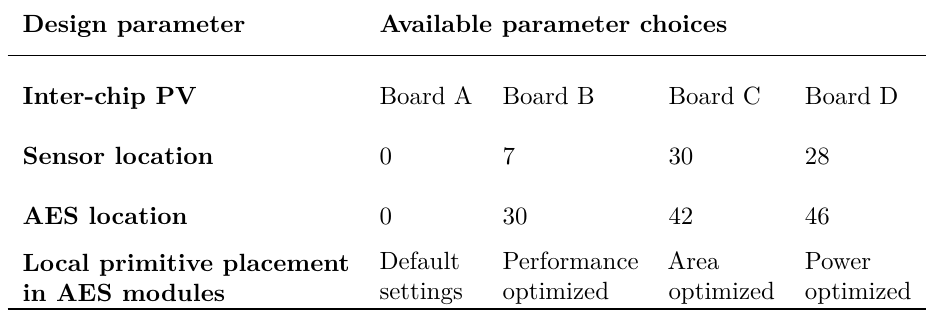
Table 1: Overview of our design space exploration, leading to 256 experiments on the success of CPA on